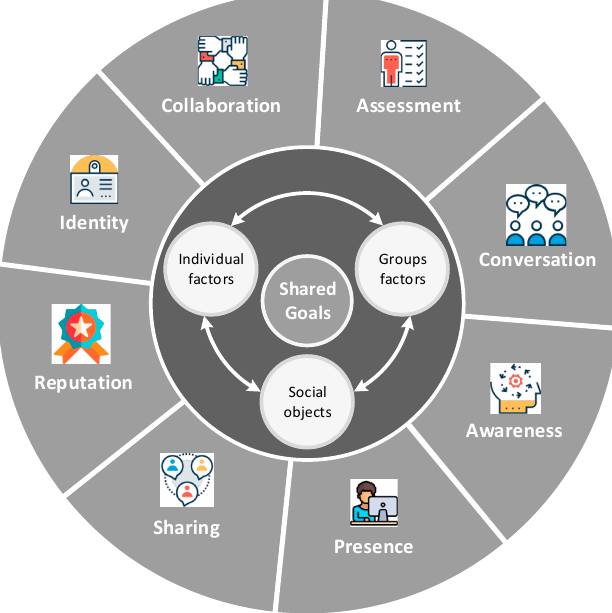
Figure 3. The COPE.er method building blocks.